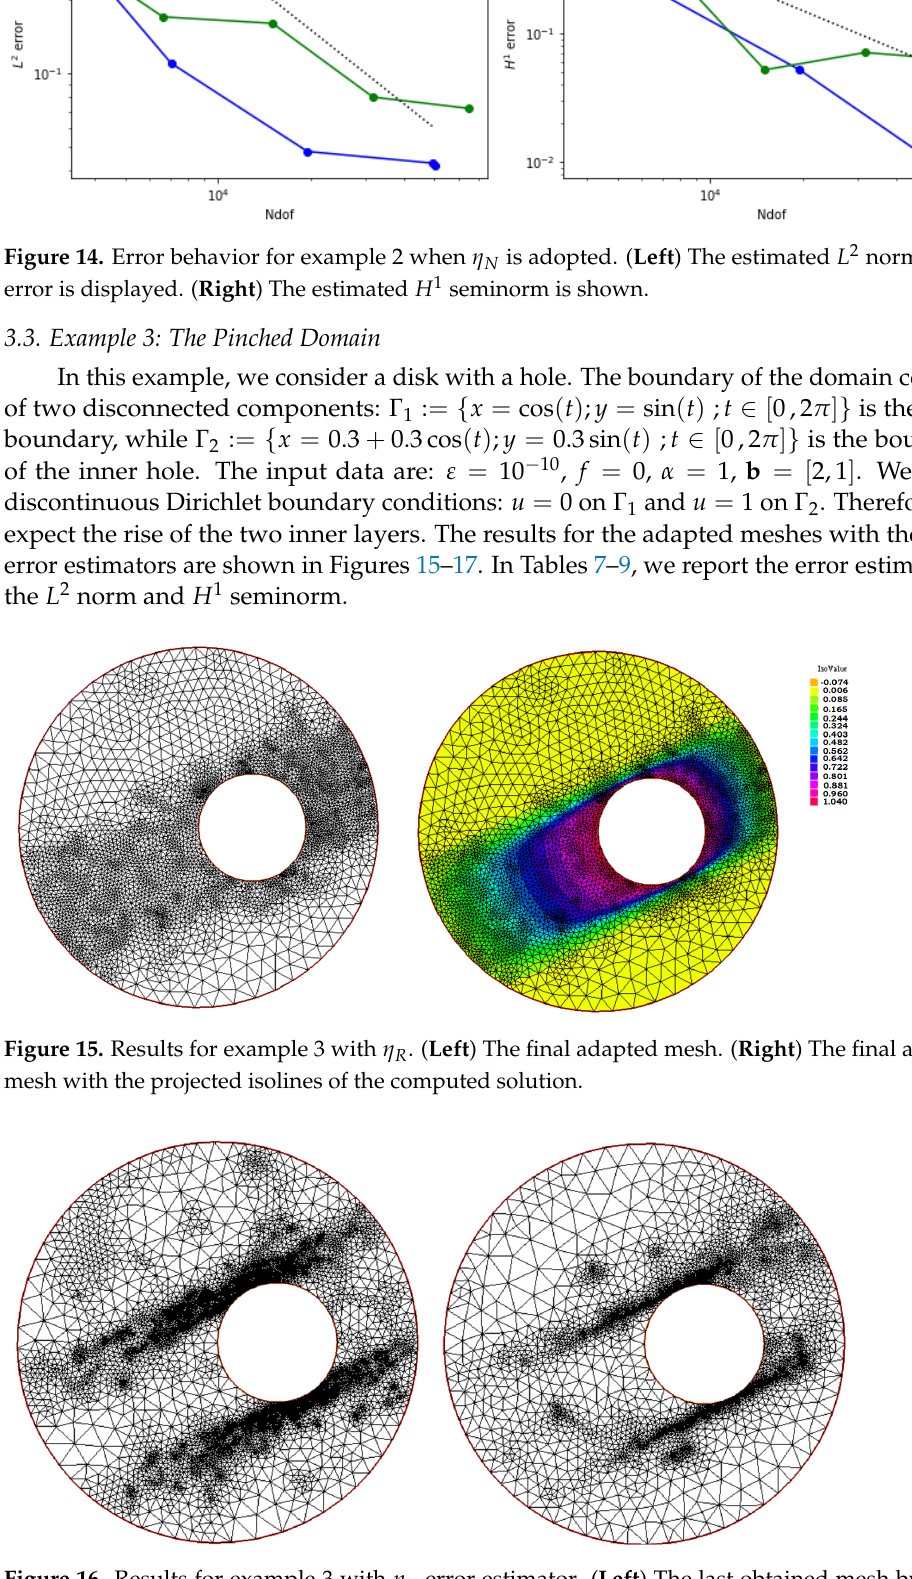
Figure 16. Results for example 3 with η Z error estimator. ( Left ) The last obtained mesh by using c = auto . ( Right ) The refined mesh at the last performed step with c =